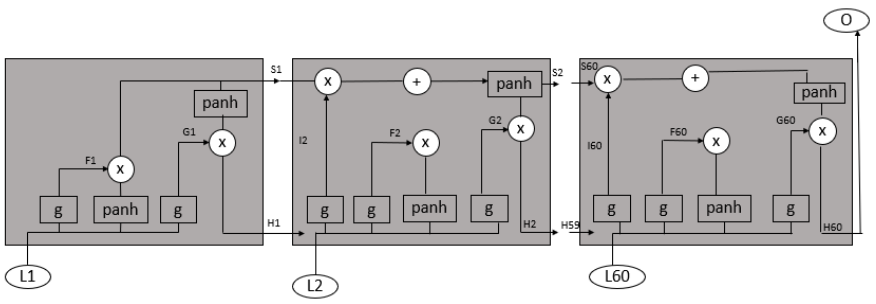
Figure 5. Basic Architecture for 60 LSTM